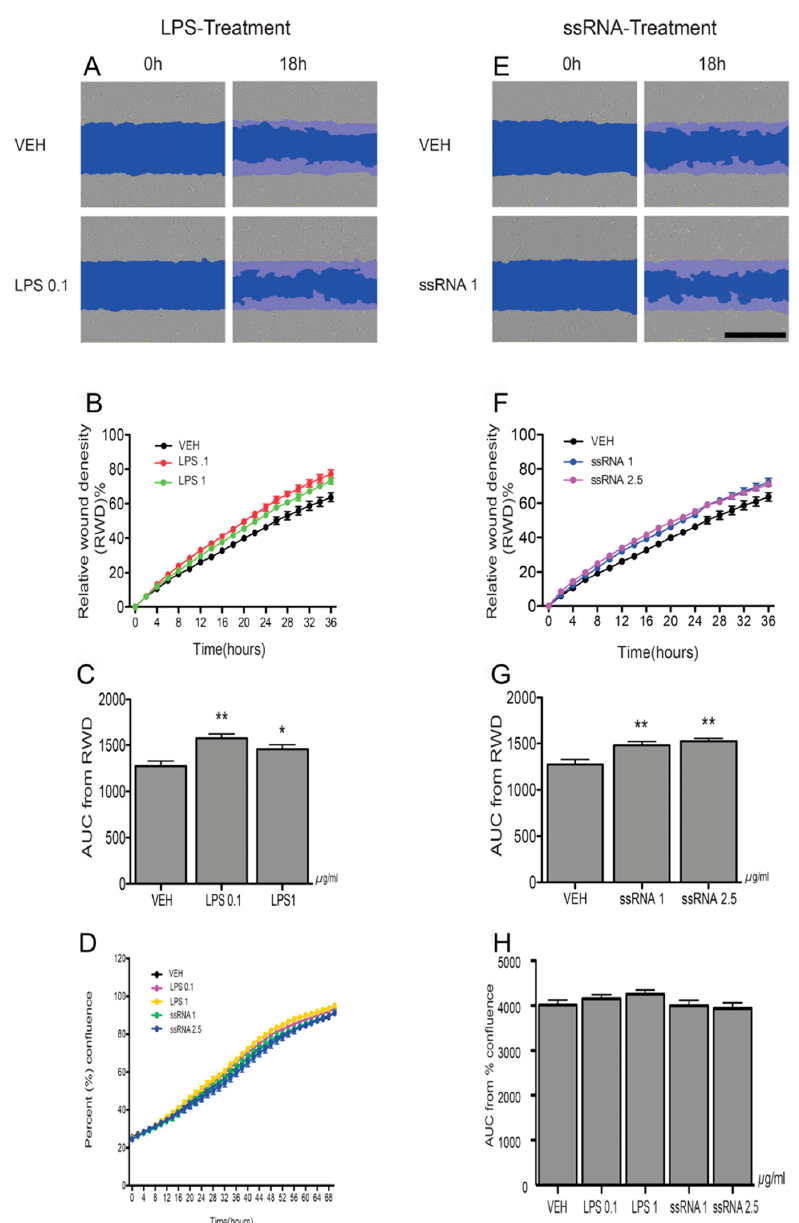
Figure 6. LPS and ssRNA induce human EVT cell migration. HTR8 / Svneo cells were cultured in 96-well plates. A wound was made on the cell monolayer using 96-well Wound Maker and cells were imaged with IncuCyte ™ ) every 2 h for 36 h post treatment (see Materials and Methods). ( A , E ) Representative images of human EVT migration at 0 h and 16 h. The wound area is artificially coloured blue to highlight the migration of cells into the wound. ( B , F ) Graphs show the relative wound density (%) in cells treated with LPS (0.1 or 1 µ g / mL) or ssRNA (1 or 2.5 µ g / mL) or their vehicle control (VEH) for 24 h. ( C , G ) Histograms show comparison between treatments depicted by Area under the curve analysis of the replicates. ( D , H ) LPS and ssRNA treatment did not a ff ect EVT cell proliferation. Cells were treated with LPS (0.1 or 1 µ g / mL) or ssRNA (1 or 2.5 µ g / mL) or their vehicle control (VEH), and time lapse imaging was performed by IncuCyteTM every 2 h for 72 h. ( D ) Percent confluence was quantified by incuCyte software. ( H ) Comparison between treatments is shown by Area under the curve analysis of the replicates. Data are expressed as means ± SEM, n = 6 per treatment group. Statistical di ff erences were tested by one-way ANOVA followed by the Newman-Keuls post-hoc test. * p < 0.05, ** p < 0.01 versus VEH. Scale bars = 600 µm.